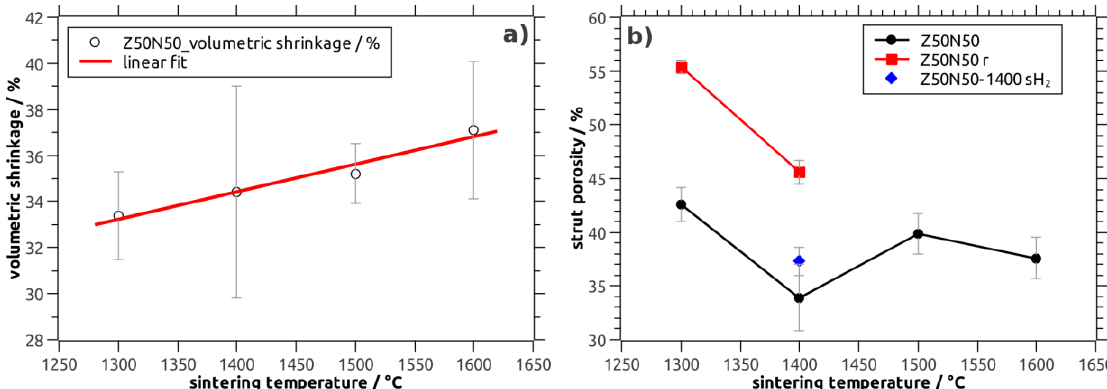
Figure 2. ( a ) Volumetric shrinkage during sintering of NiO–YSZ composite foams (Z50N50 series) as a function of the sintering temperature; ( b ) strut porosity in NiO–YSZ and Ni–YSZ cellular composites as a function of the sintering temperature.